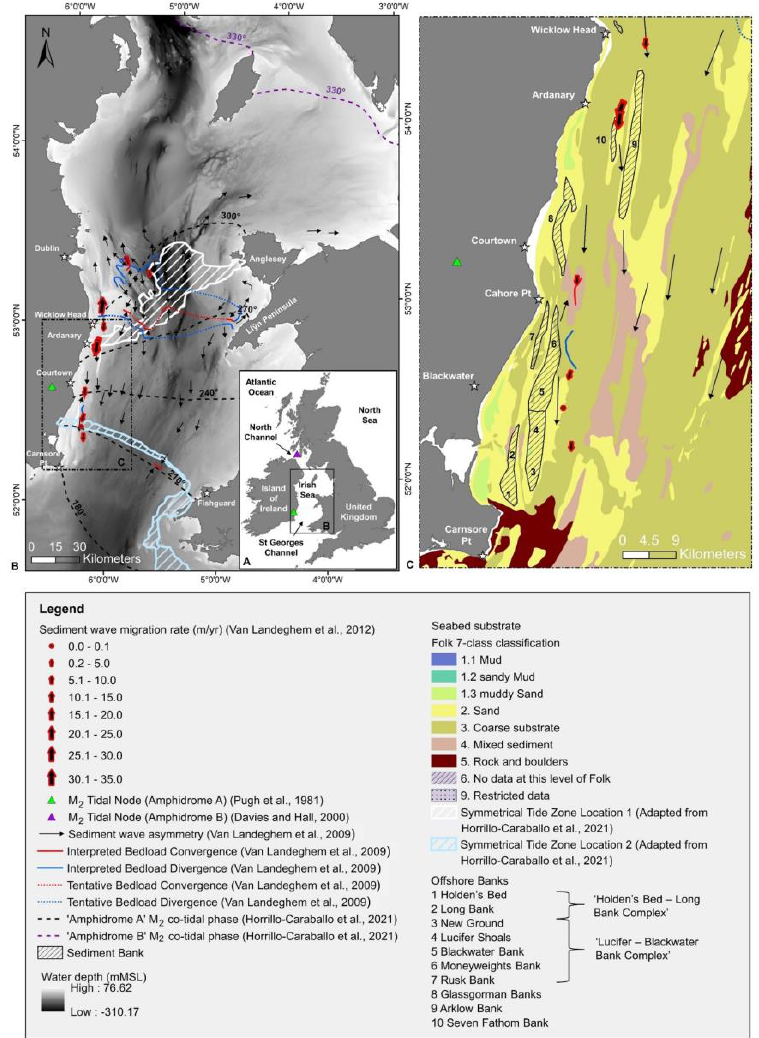
Figure 1. Maps showing pre-existing knowledge of Irish Sea sediment transport. ( A ) Location of the Irish Sea on the north-western European continental shelf. ( B ) Irish Sea hydrodynamic and sediment transport characteristics. The location of the bedform derived bed load parting zone, defined by Van Landeghem, et al. [39], characterised by one main sediment transport convergence zone and two divergent zones, is indicated. Bathymetry source: EMODnet Bathymetry Consortium [40]. ( C ) Study area displaying sediment distribution and main offshore sediment banks. Seabed substrate source: European Marine Observation Data Network (EMODnet) Seabed Habitats initiative ( http: //www.emodnet-seabedhabitats.eu/ [Accessed: 25 June 2021])